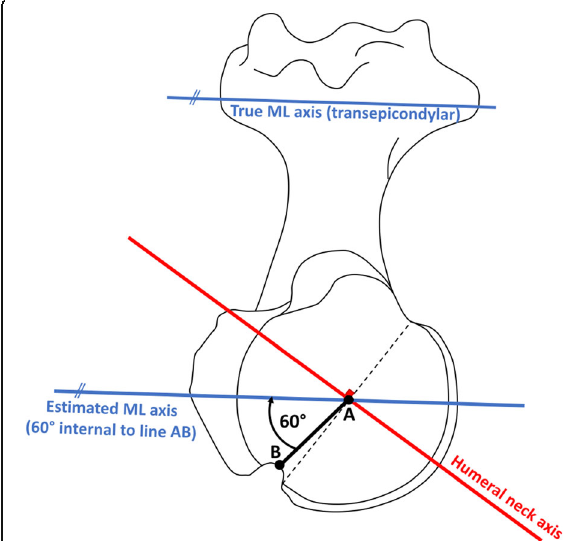
Fig. 2 Estimation of the Medio-Lateral (ML) axis based on the centers of the humeral head ( a ) and of the bicipital groove at its proximal portion ( b